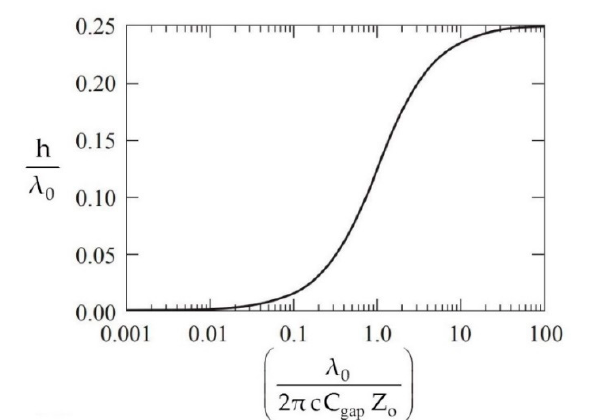
Figure 3. Universal tuning curve to determine the reentrant cavity resonator length normalized to the free-space wavelength of the microwave frequency in the resonator [23].